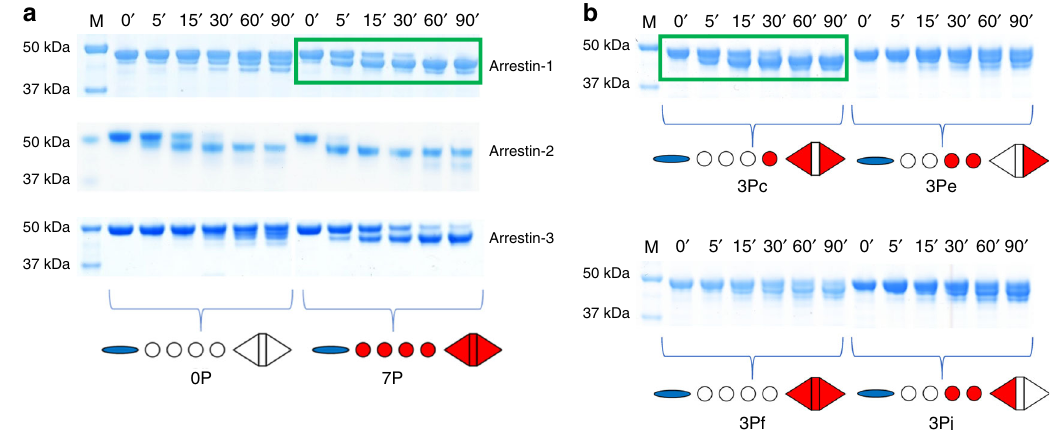
Fig. 3 Conformational change of arrestins depend on phosphorylation pattern. a Limited trypsin digest of arrestin-1, -2 and -3 in presence of non- (0P) and fully phosphorylated (7P) phosphopeptide analogs of the rhodopsin C-terminus. The presence of fully phosphorylated peptide resulted in a change of the digestion pattern from three to two bands in comparison to nonphosphorylated peptide for arrestin-1 and -3. The digestion of arrestin-2 always resulted in two bands with similar molecular weight as arrestin-1/-3 independent of which peptide was present. However, digestion was accelerated in the presence of fully phosphorylated peptide as compared to nonphosphorylated peptide. b Limited trypsin digestion of arrestin-1 in the presence of different tri- phosphorylated peptides. Peptide-induced conformational changes in arrestin-1 are indicated by a change in the digest pattern (green boxes) (Source data are provided as a Source Data fi